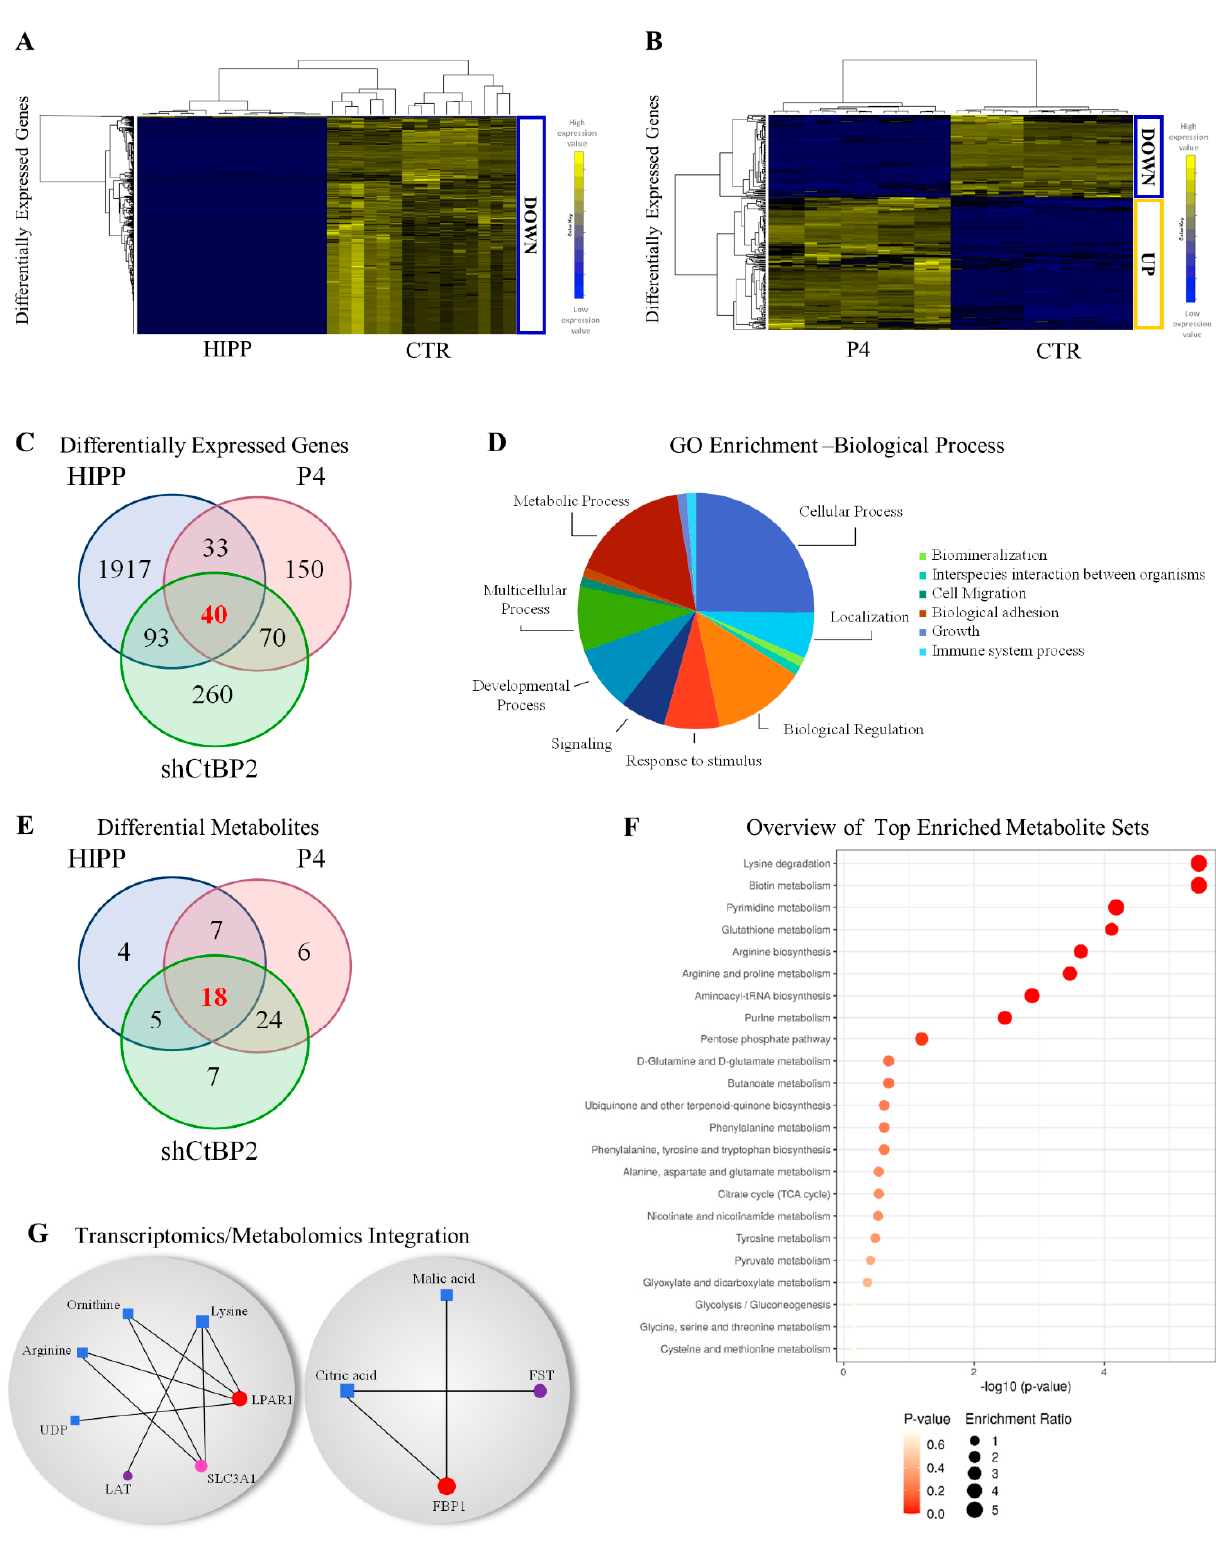
Figure 4. Transcriptomics/metabolomics integration of MDA-MB231 cells under HIPP and P4 chemical CtBP2 inhibitors. ( A , B ) Hierarchical clustering and heatmaps of differentially expressed genes in MDA-MB231 cells between the control and cells treated with HIPP (left), or the control and cells treated with P4 (right). The colors represent different expression levels that increase from blue to yellow. ( C ) Venn diagram of differentially expressed genes in HIPP, P4, and shCtBP2 compared to scramble. ( D ) Gene ontology enrichment analysis of the biological process of differentially expressed genes represented as a pie chart of the 40 common differentially expressed genes in HIPP, P4, and shCtBP2 vs. scramble cells. ( E ) Venn diagram of differential metabolites in HIPP, P4, and shCtBP2 compared to scramble. ( F ) Quantitative pathway